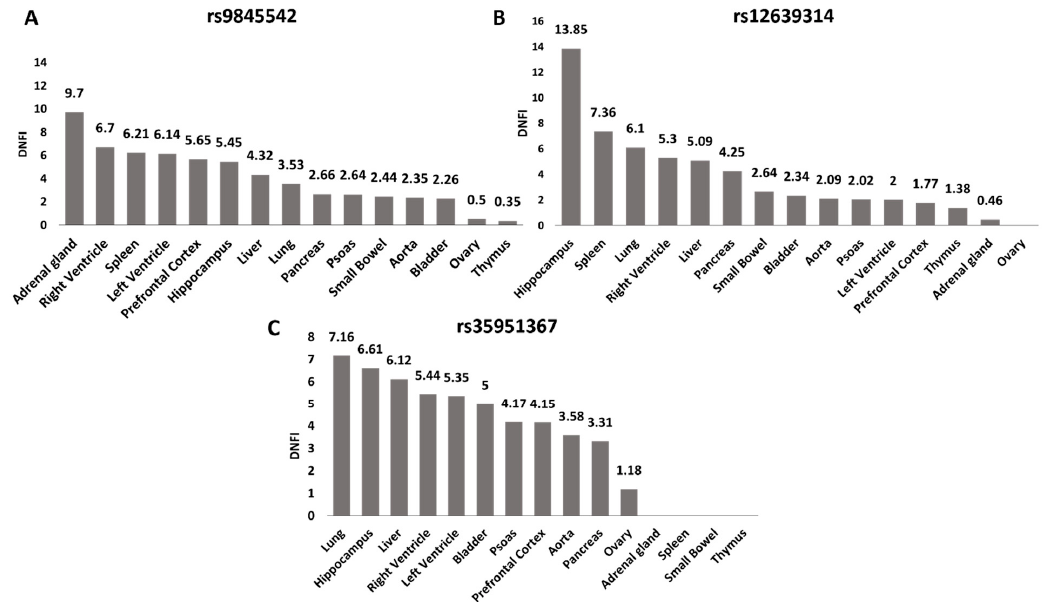
Figure 3. rs35951367 is located in the genomic region with the highest level of interaction with CCR5 in lung. For all SNPs, the level of interaction with CCR5 as Distance Normalized Interaction Frequency (DNIF) in all tissues is shown. ( A ) DNIF of rs9845542; ( B ) DNIF of rs12639314 and ( C ) DNIF for rs35951367. The highest levels of interaction with CCR5 in lung were found for the ( C ) rs35951367 SNP. Data were retrieved from the 3DIV database (http://kobic.kr/3divv1/, accessed on 10 May 2021).